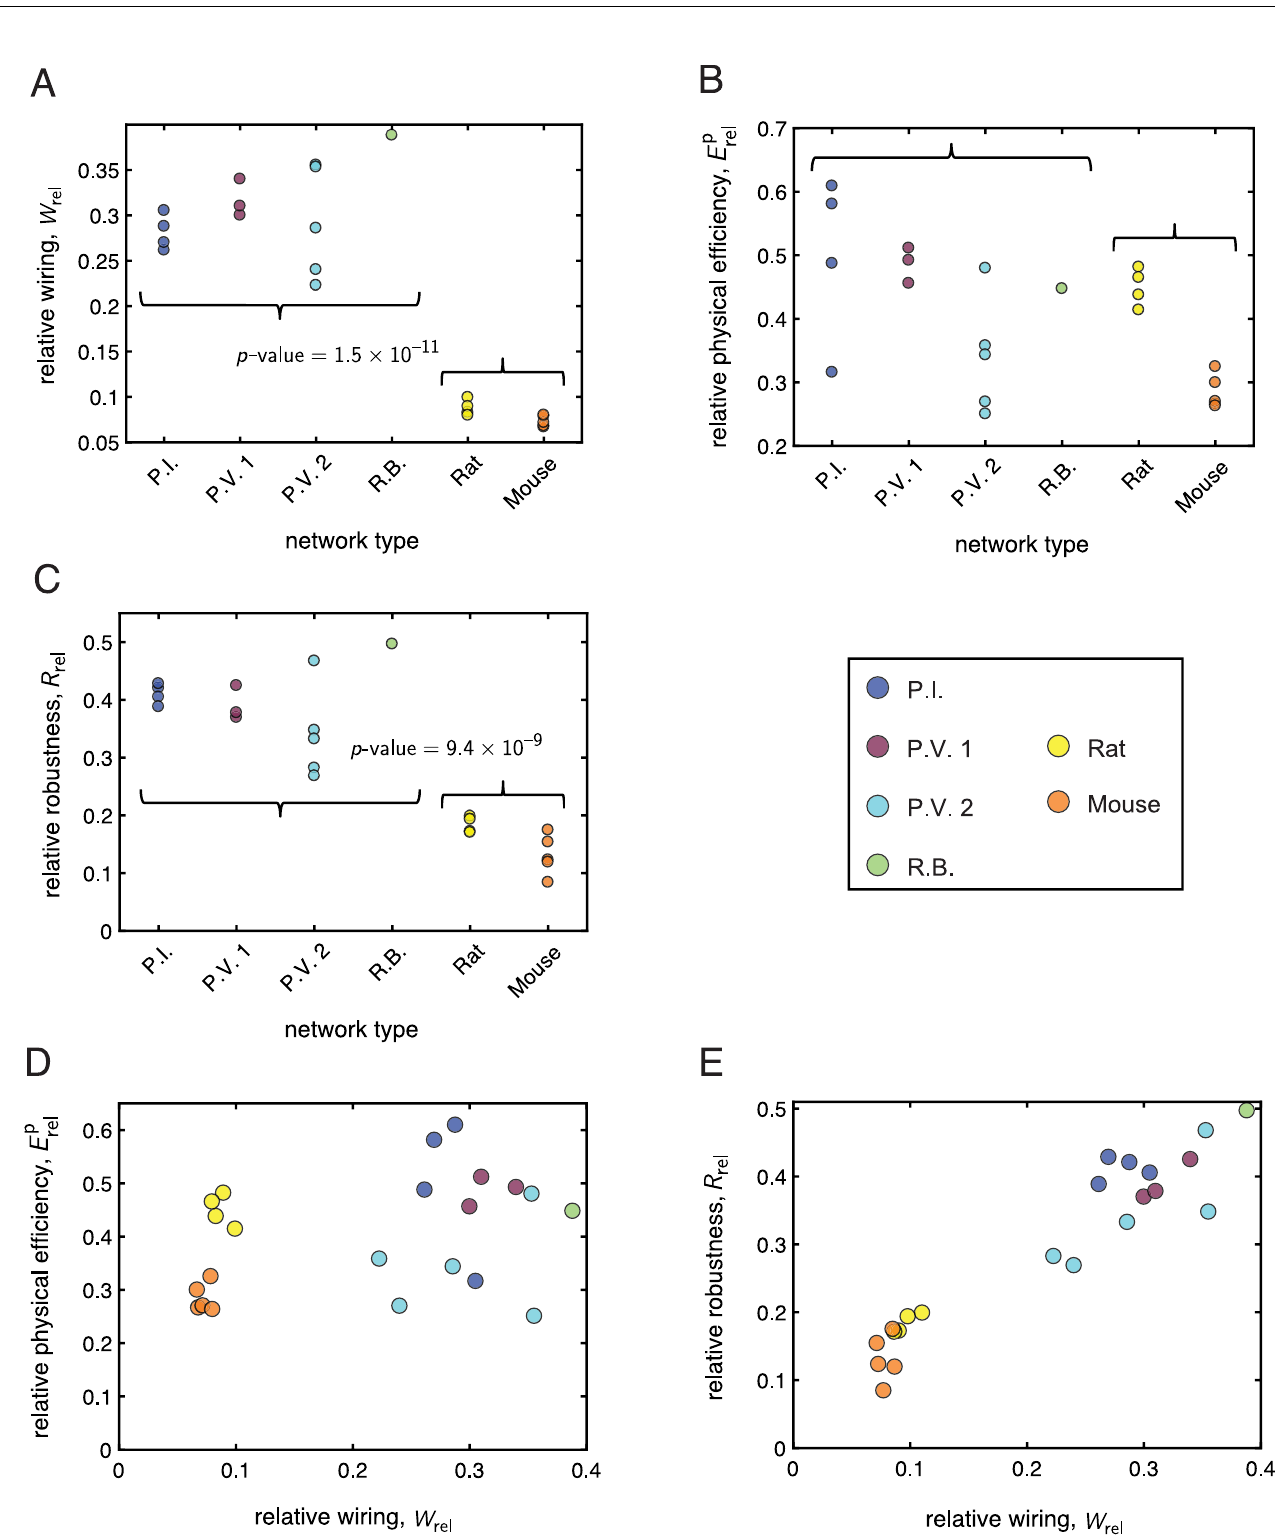
Fig 7. Mycelial and vasculature networks exhibit distinct tradeoffs between wiring, physical efficiency, and structural robustness. In panels (A-C) the x - axis labels the kind of network, with the curly braces grouping the mycelia (first 4 networks) and the vasculature (last 2 networks). The y -axis measures the value of a given property for each network. A p -value is displayed if there was a statistically significant difference (as determined by a two-sample t -test) in the mean value of the given property between the population of mycelial networks and the population of vasculature networks. (A) The mean relative wiring for